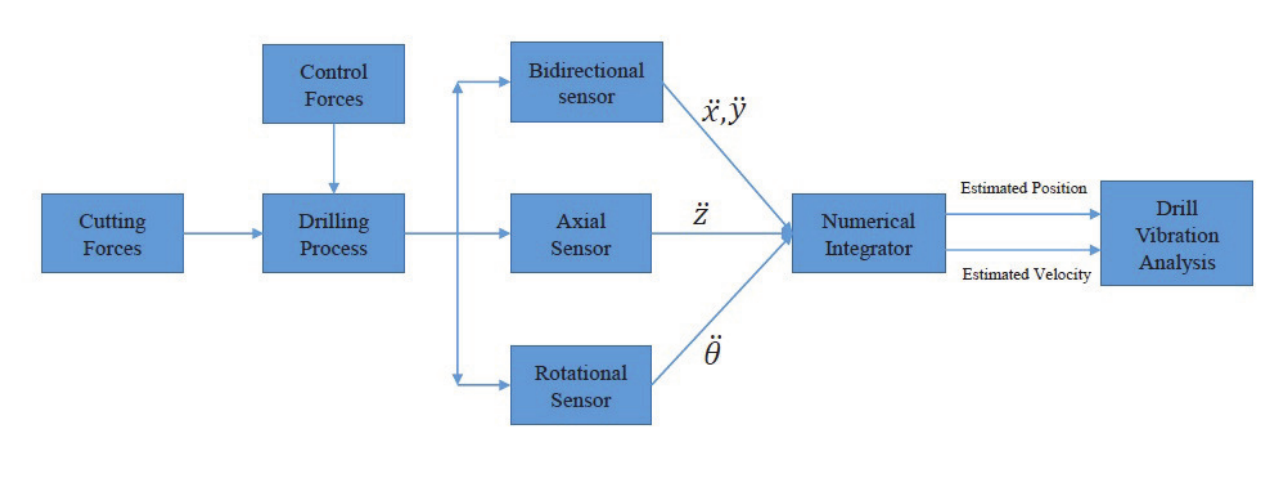
Figure 2. Block diagram of drilling simulation without fault.